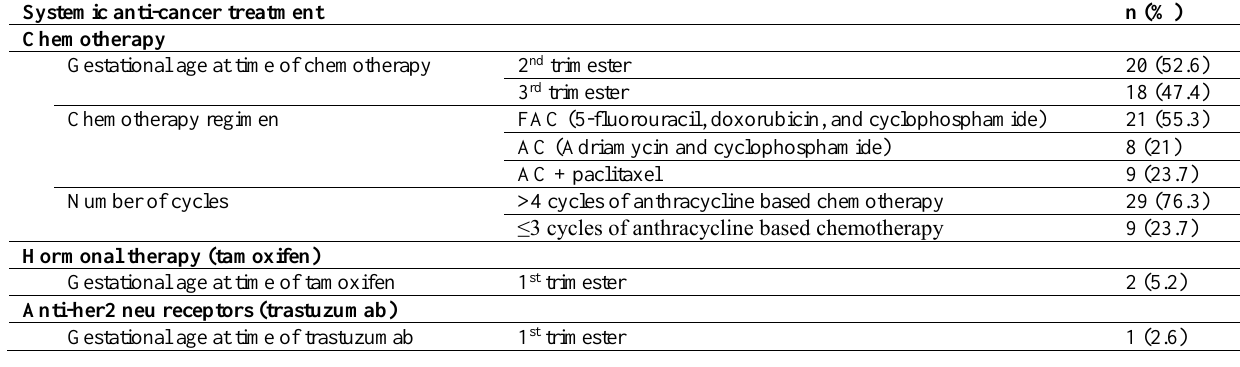
Table 1: Systemic anti-cancer treatment in 38 patients with pregnancy-associate breast cancer Systemic anti-cancer treatment Chemotherapy Gestational age at time of